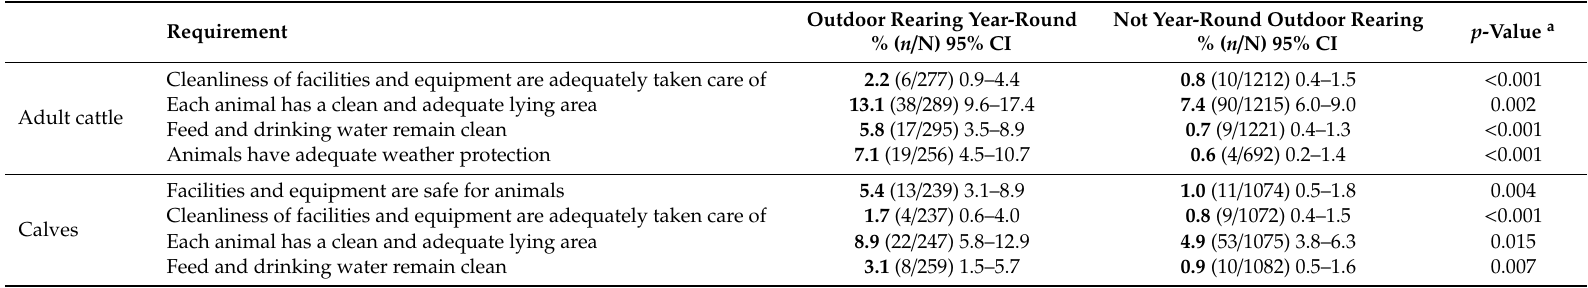
Table 7. Statistically significant di ff erence for certain requirements between the cattle farms rearing their cattle outdoors year-round versus farms which do not rear outdoors